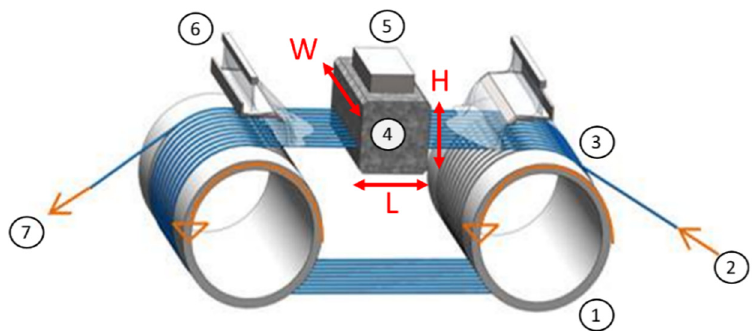
Figure 3. 1: Wire guide rollers; 2: Fresh wire; 3: Wire web; 4: Workpiece; 5: Top plate; 6: Slurry nozzles; 7: Used wire (H—height; L—length, W—width of the workpiece) [10].